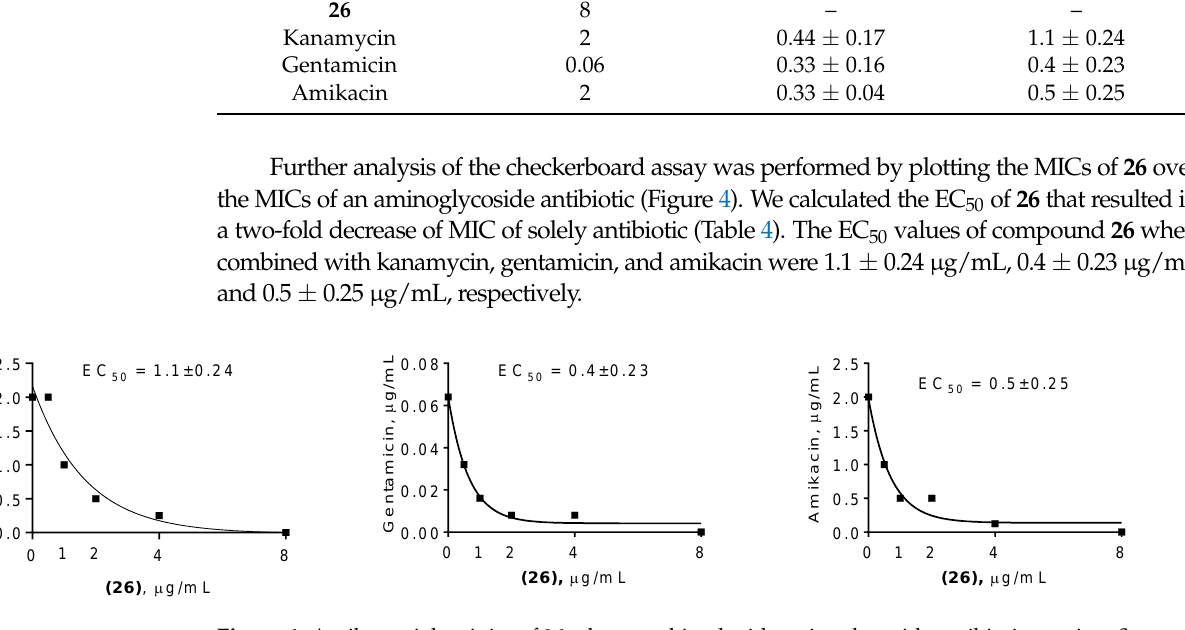
Figure 4. Antibacterial activity of 26 when combined with aminoglycoside antibiotics against S. aureus . The EC 50 of 26 was calculated as the concentration of the antimicrobial agent that reduced two-fold MIC of an antibiotic and presented in µ g/mL; mean ± SD from five calculations is shown.